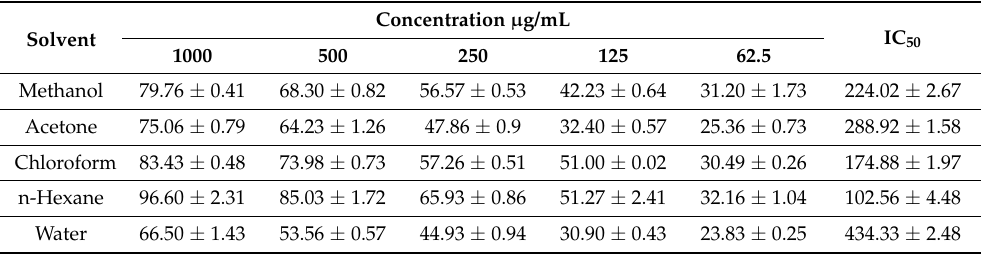
Table 2. IC 50 values of DPPH